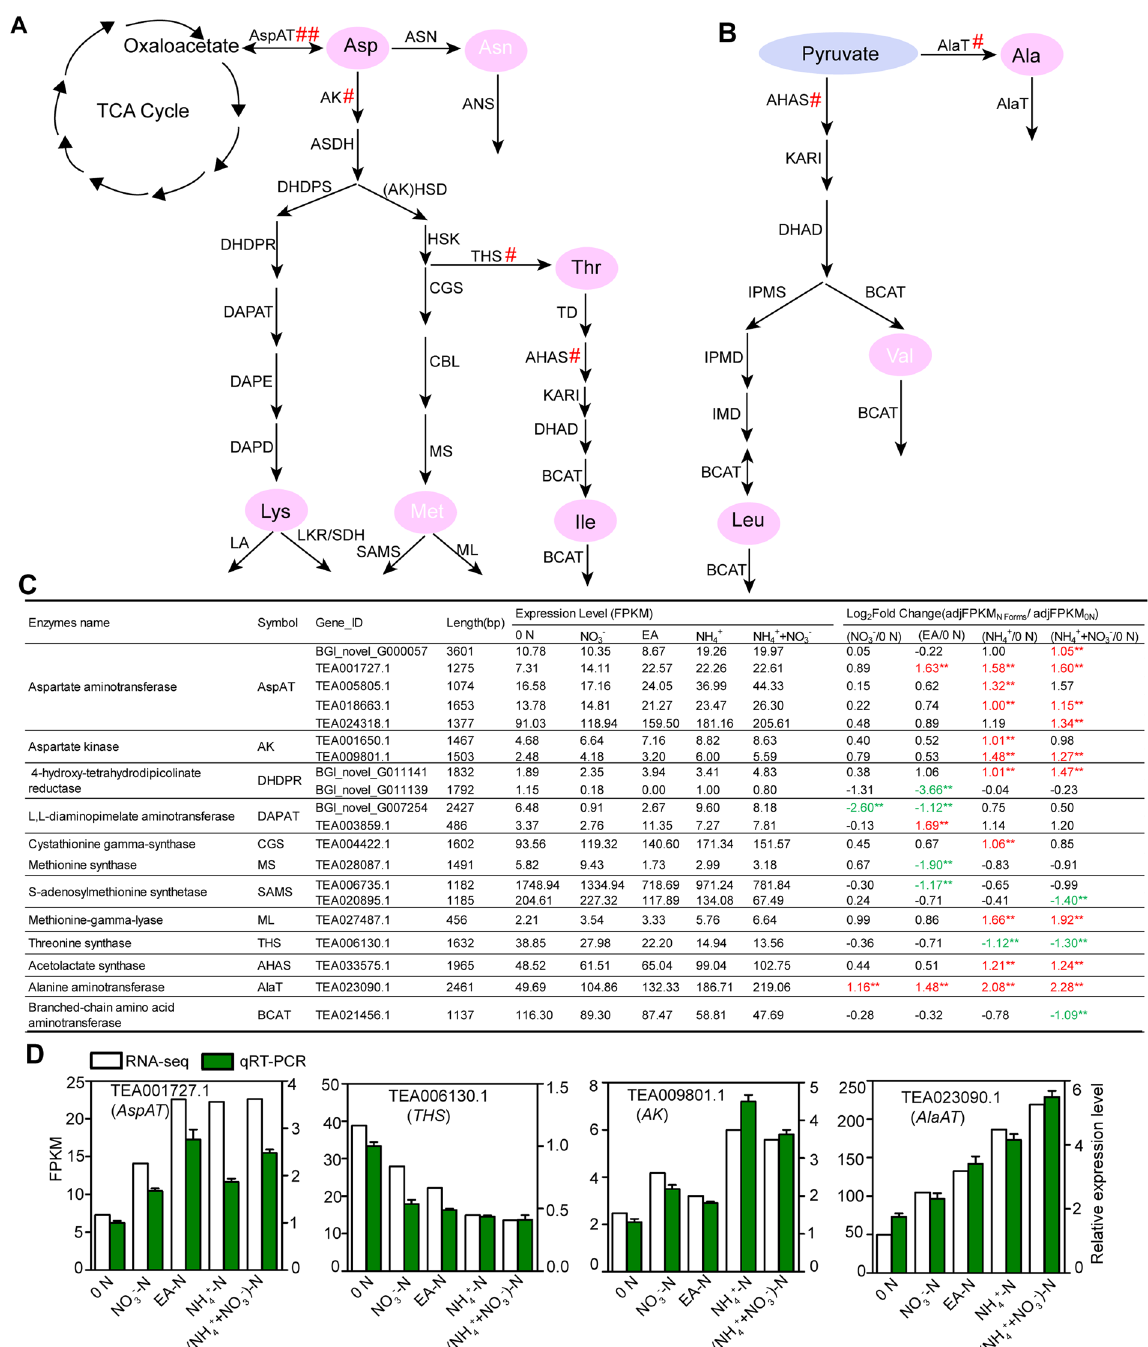
Figure 6. Identification of DEGs encoding enzymes related to Asp and pyruvate pathway. ( A ) The DEGs encoding enzymes related to synthesis and first step degradation pathway of Asp and pyruvate-derived amino acids. ( B ) Expression levels and relative fold change (log 2 ( adj FPKM N forms / adj FPKM 0 N ) of DEGs related to Asp- derived and pyruvate amino acids. The table indicates genes with significant changes (fold change ≥ 2, p < 0.05; marked by two asterisks and number in red or green) in 0 N versus different N forms. 0 N, N free; NO 3 − , NO 3 − -N, EA, Ethylamine-N; NH 4 + , NH 4 + -N; (NH 4 ++ NO 3 − ), (NH 4 + + NO 3 − )-N. ( C ) Quantitative real-time PCR validation for potential candidate genes. The relative expression levels and FPKM values are